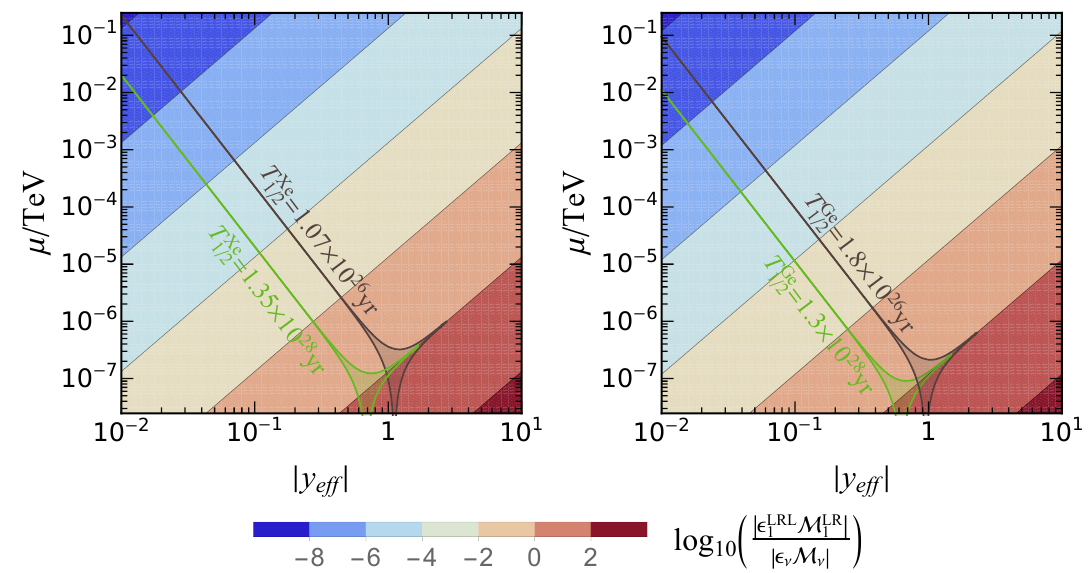
Figure 13 . The relative size of the short-range mechanism and mass mechanism to the decay rate in the plane µ versus the couplings y eff . The mass mechanism is dominant in the blue region while the short-range mechanism is dominant in the dark red region. The shaded regions denote the contours of the current limit and future sensitivities in 136 Xe (left) and 76 Ge (right) 0 νββ decay search, where the phase α − β freely varies between 0 and π